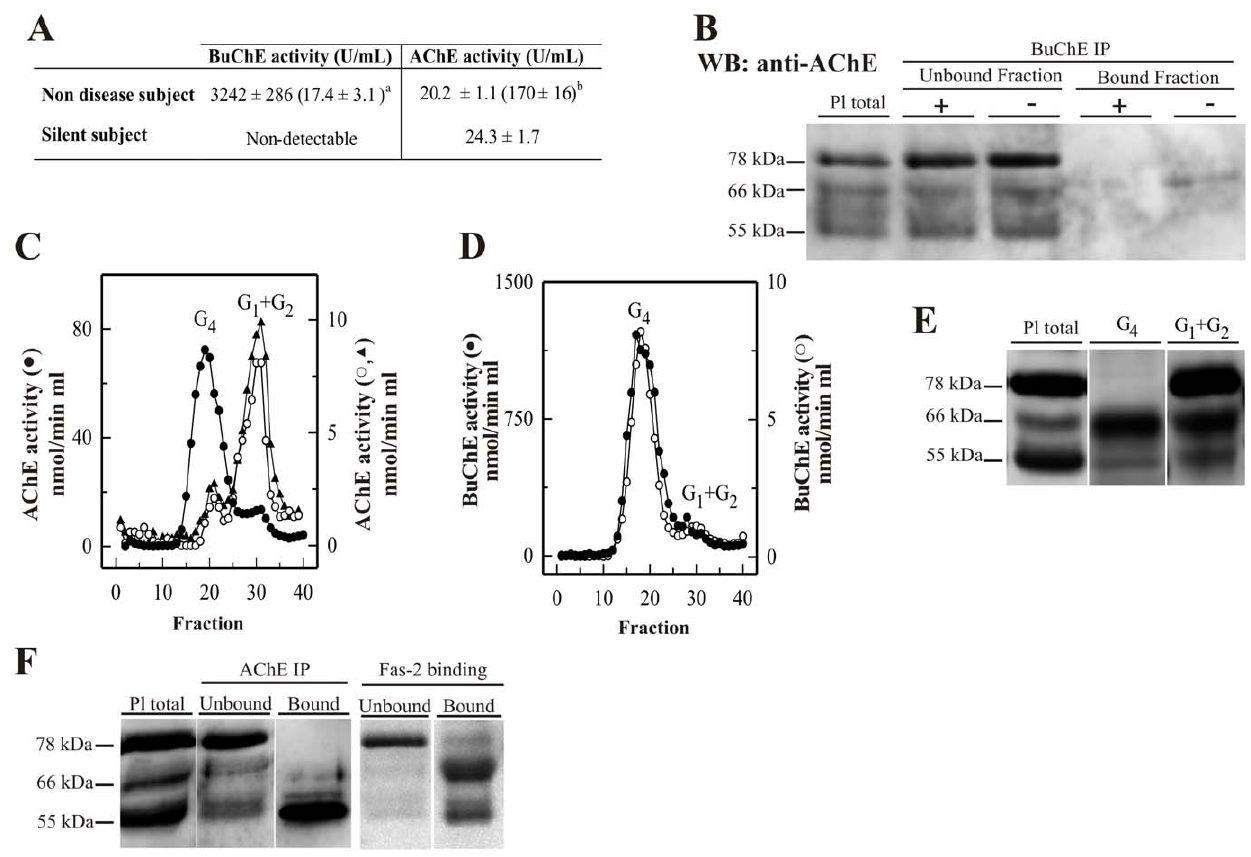
Figure 1. Plasma AChE levels in healthy controls (wild-type) after BuChE immunodepletion and in BuChE-silent individuals. ( A ) Control plasma was immunoprecipitated with anti-BuChE antibody and cholinesterase activity levels determined before b and after a immunoprecipitation (n=6; 46 6 4 yrs). AChE activity level in plasma from BuChE-silent individuals is also shown (n=3; 30 6 5 yrs). The anti-BuChE antibody does not immunoprecipitate AChE in BuChE-silent plasma (not shown). Values are means 6 SEM. ( B ) Immunoprecipitation of control plasma with antibody, followed by immunoblotting with the anti-AChE antibody, N-19. The presence ( + ) or absence ( 2 ) of the anti-BuChE antibody linked to the resin is indicated in the top margin. Prior to electrophoretic analysis, proteins abundant in plasma were depleted by immunoaffinity- based protein subtraction chromatography with IgY microbeads (Seppro TM ). The anti-BuChE antibody does not immunoprecipitate AChE. Extracts incubated with protein A-Sepharose, in the absence of the antibody, were analyzed in parallel as negative controls. ( C ) Representative profiles of AChE and ( D ) BuChE molecular forms (G 4 =tetramers; G 1 + G 2 =monomers and dimers) in control plasma samples before ( immunoprecipitation, and in BuChE-silent plasma ( m ). ( E ) Representative immunoblot of individual AChE G 4 and G 1 + G 2 peak-fractions separated by sucrose gradient centrifugation from control plasma and detected with the N-19 antibody (a similar volume for both the G 4 and G 1 + G 2 peaks was loaded in each lane). ( F ) Comparison of the AChE-banding pattern detected with the N-19 antibody, for fractions bound and unbound to the anti- AChE antibody HR2 and to the Fas2-Sepharose affinity matrix.